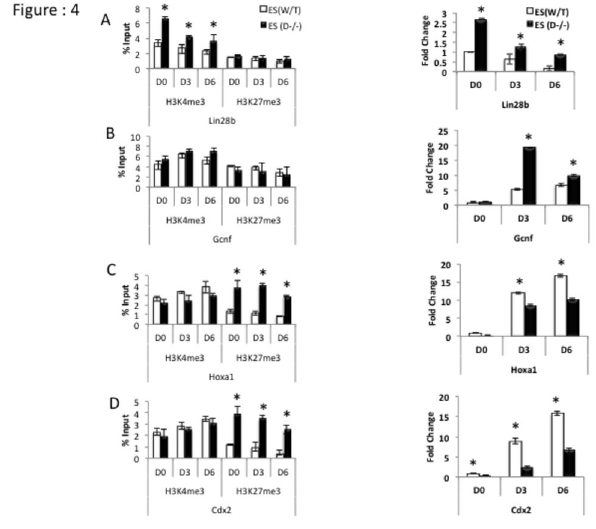
Figure 4. Transcriptionally favorable H3K4me3 modifications in promoter regions increase expression levels of Lin28 b in Dicer -/- ES cells relative to WT ES cells, while H3K27me3 histone modifications disfavor Hoxa1 and Cdx2 expression in Dicer -/- ES cells relative to WT. ES. AB C and D left panels, ChIP- qPCR results on promoter regions and qRT-PCR results (Right panles) of Lin28 b, Gcnf , Hoxa1 and Cdx2 respectively upon RA induction from day 0 (D0) through day 6 (D6). Note higher enrichment levels of H3K4me3 in the promoter regions of Lin28 b (A left panel) which affect increased expression levels in Dicer -/- ES cells (A right panel). As shown in C and D left panels higher occupation of H3K27me3 in Hox a1 and Cdx2 attenuates upregulation of transcripts in Dicer -/- ES cells compared to WT ES cells (C and D right panels). The symbol * indicates that the difference at a given time point between the two cell lines were significant at 0.05 confidence levels when a students t-test was